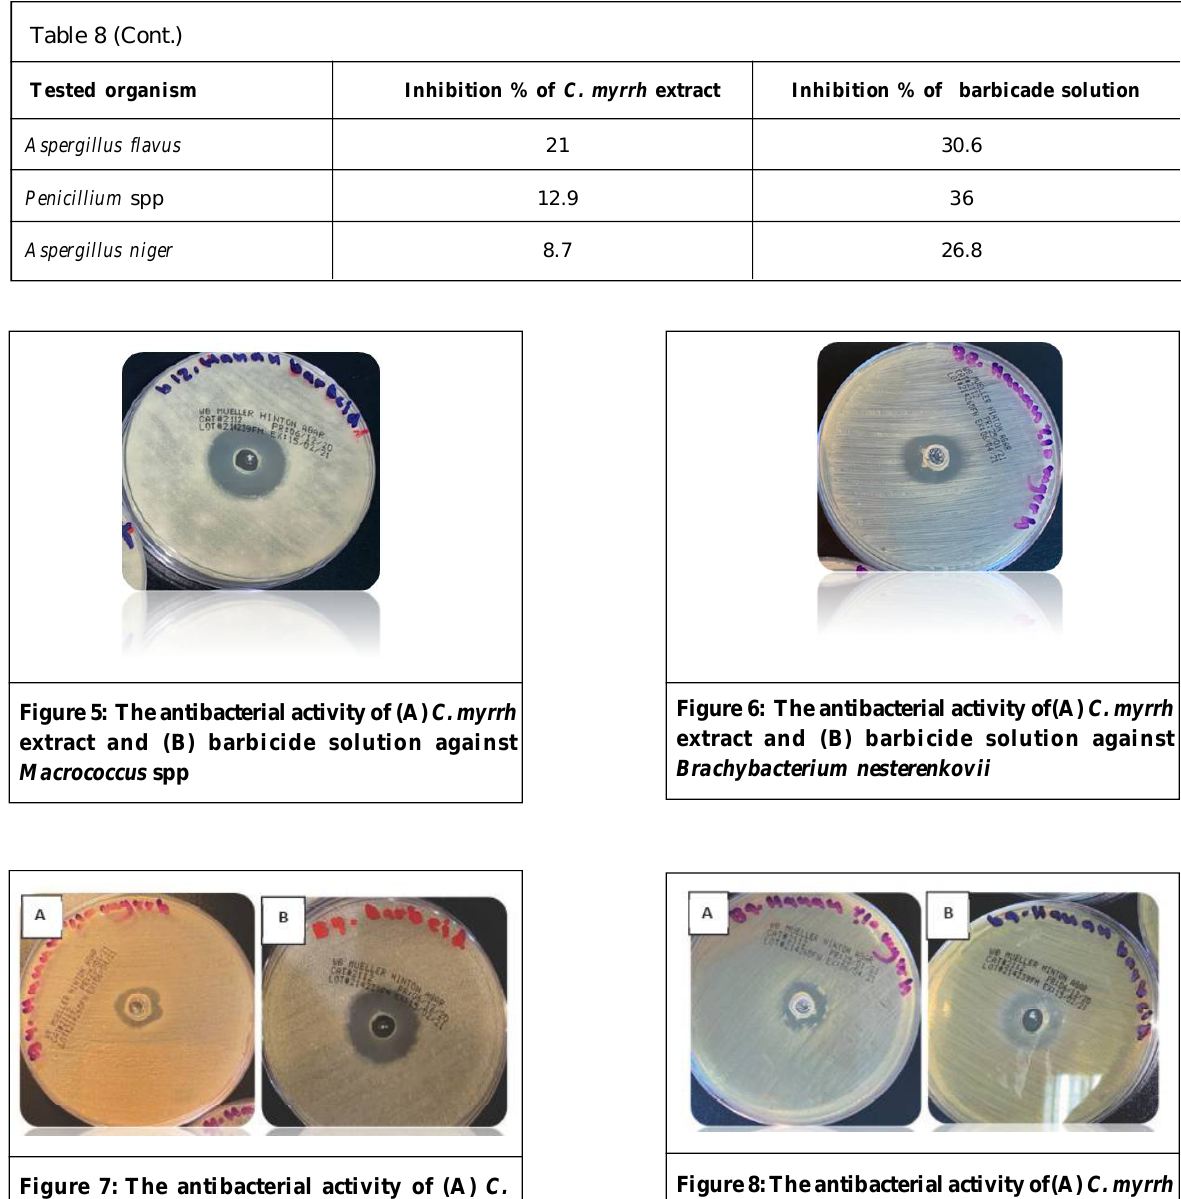
Figure 7: The antibacterial activity of (A) C. myrrh extract and (B) barbicide solution against Bacillus subtilis